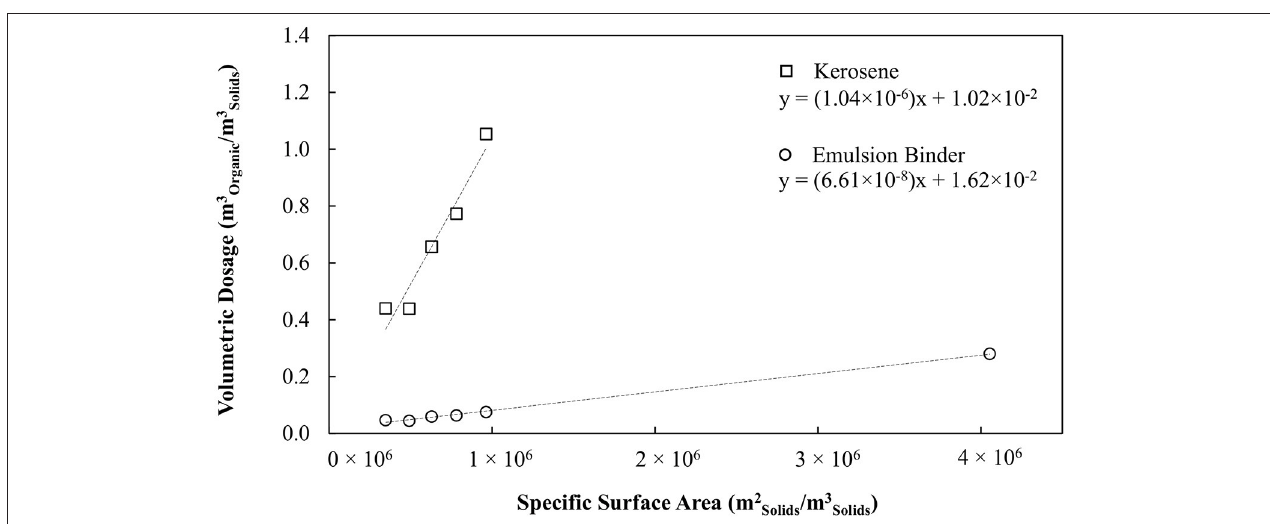
FIGURE 1 | Organic liquid dosage as a function of specific surface area of solid particles. Adapted with permission from van Netten et al. (2017). Copyright 2017 American Chemical Society.